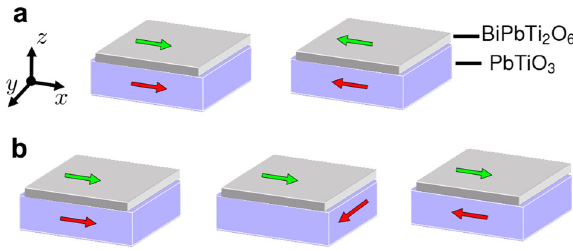
Fig. 6 Multifunctions of the BPTO/PbTiO 3 heterostructure. a At high temperature, the energy barrier is easily surmounted by thermal fl uctuations and the polar displacements of BPTO can be switched. From the left panel to the right panel, as an electric fi eld swiches the polarization of PbTiO 3 , the BPTO thin fi lm follows the change and switches its polar displacements via the interfacial coupling. b At low temperature, the energy barrier can not be overcome and the polar displacements of BPTO get “ stuck ” . However, an electric fi eld can switch the polarization of PbTiO stabilize multiple states with different orientation of PbTiO 3 polarization relative to the polar displacements of BPTO. Each state has different tunnelling barriers. From the left panel to the right panel, it is “ parallel ” , “ perpendicular ” , and “ anti-parallel ” state. The red arrow refers to the polarization of PbTiO 3 thin fi lm. The green arrows refer to the polar displacements of BiPbTi 2 O 6 thin fi lm.